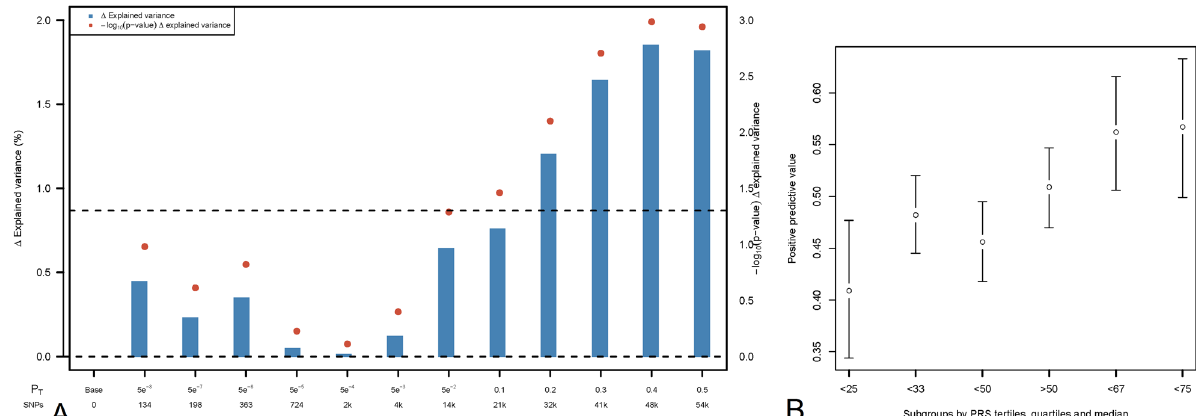
Fig. 2 Association between symptom severity while on clozapine and polygenic risk scores for schizophrenia. A, B . Bar plot illustrating the explained variance for the association of schizophrenia-PRS with binary outcome at several p t , adjusted for sex, age, and 10 PCs. p t are displayed on the X-axis, where the number of included SNPs increases with more lenient p t . Δ Explained variance represents the Nagelkerke R 2 (shown as %). The red dots represent the signi fi cance of the association results (-Log 10 p value). The dashed line represents a nominal signi fi cance-level of p < 0.05 ( A ). Individual risk prediction: higher schizophrenia-PRS was associated with higher positive predictive value for low symptom severity. Whiskers represent con fi dence intervals (±1.96 × standard error) around the central positive predictive value estimate ( B